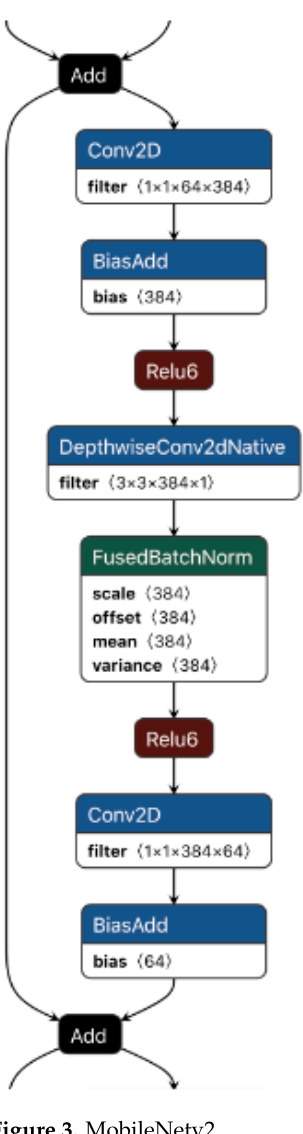
Figure 3. Figure 3. MobileNetv2.